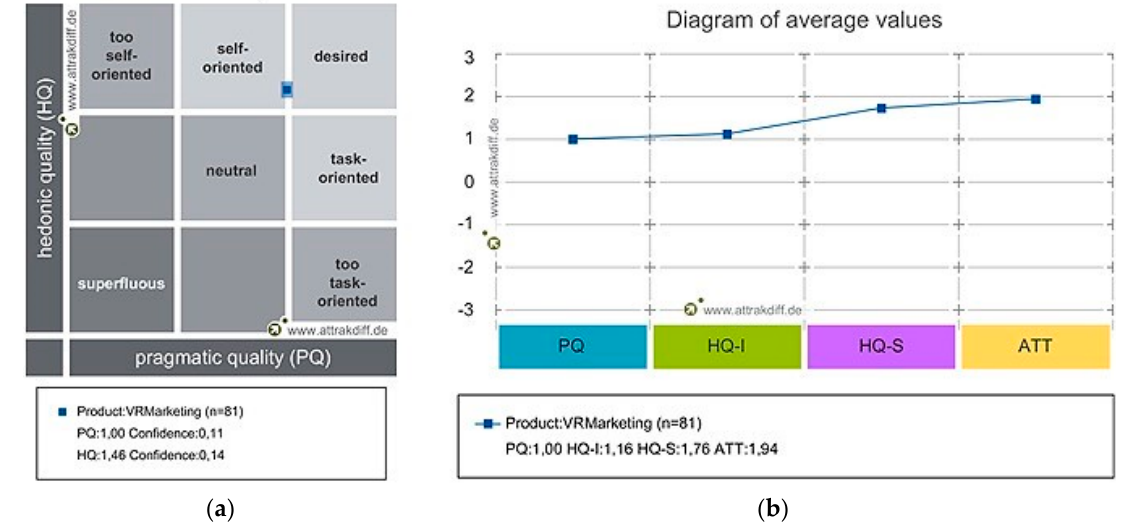
Figure 7. AttrakDiff General Result. ( a ) Portfolio of results; ( b ) Diagram of average